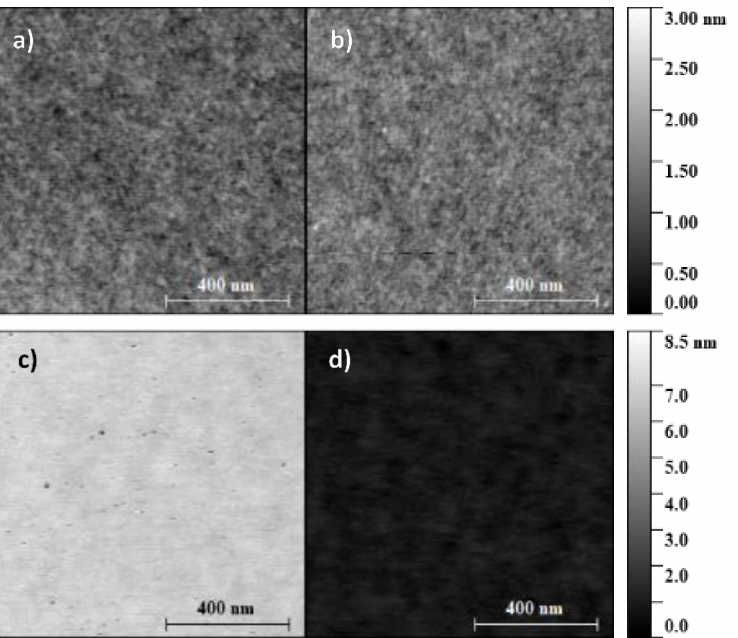
Figure 4. Atomic force microscope topography ( a , b ) and electrostatic force microscope images ( c , d ) of gate dielectrics without a BQMI layer (left side) and coated with BQMI 2 (right